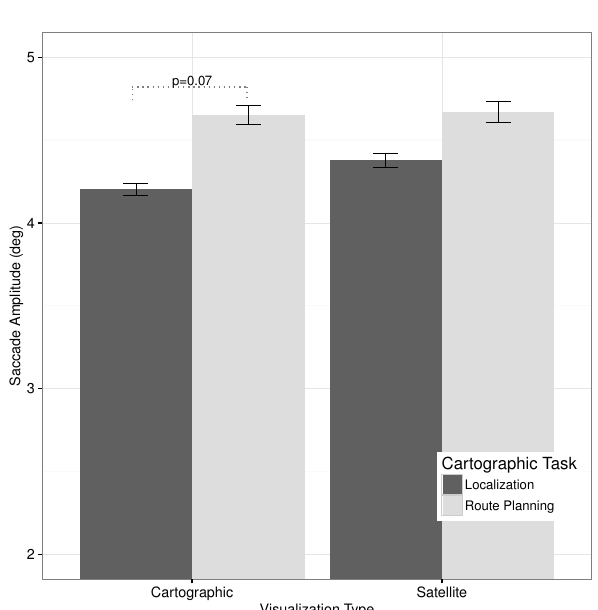
Figure 4 . Marginally significant interaction e ff ect of task and visualization on average saccade amplitude. Whiskers repre- sent ± 1SE (standard